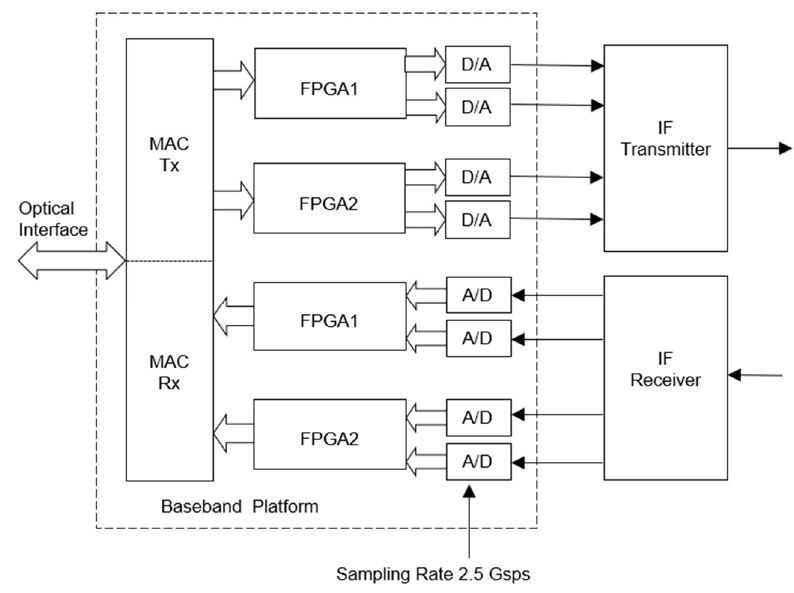
Figure 2. Structure of the proposed base-band module.